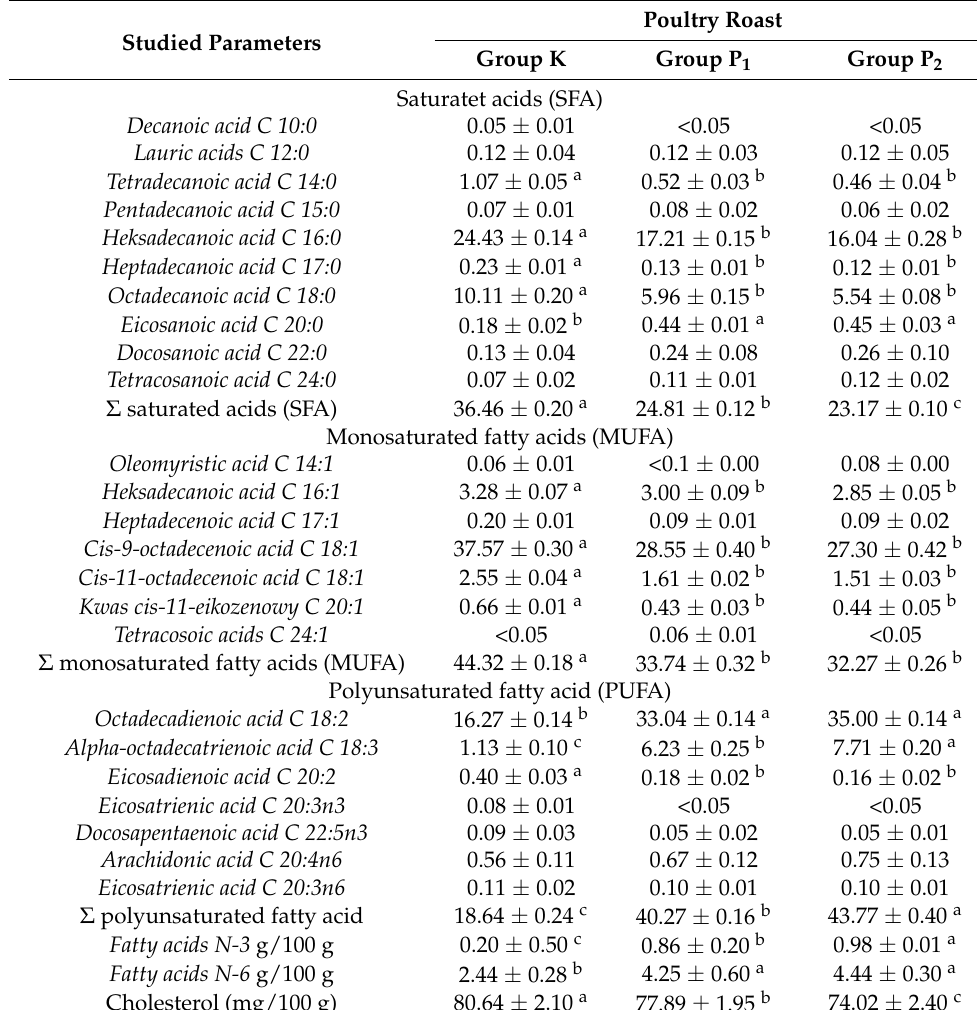
Table 4. Impact of enrichment with seeds, flour, and hemp oil on the fatty acid profile of poultry roast (x ±